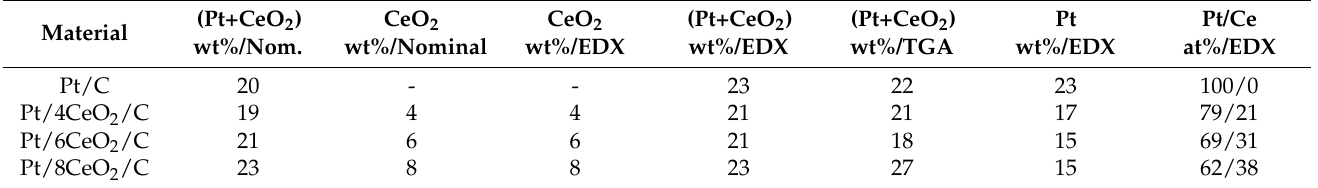
Table 1. EDX and TGA mass compositions, and EDX and XPS atomic compositions of Pt/CeO 2 /C catalysts. (Pt+CeO 2 ) Material